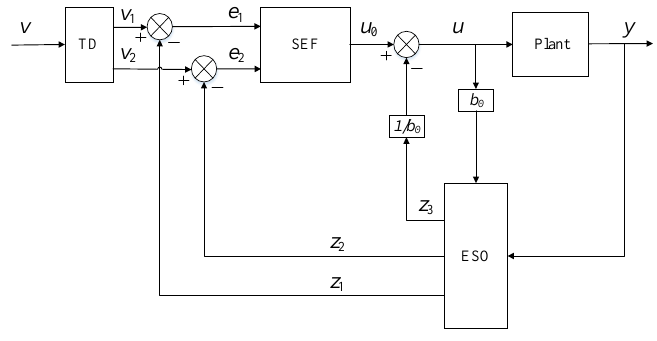
Figure 6. The schematic diagram of ADRC.